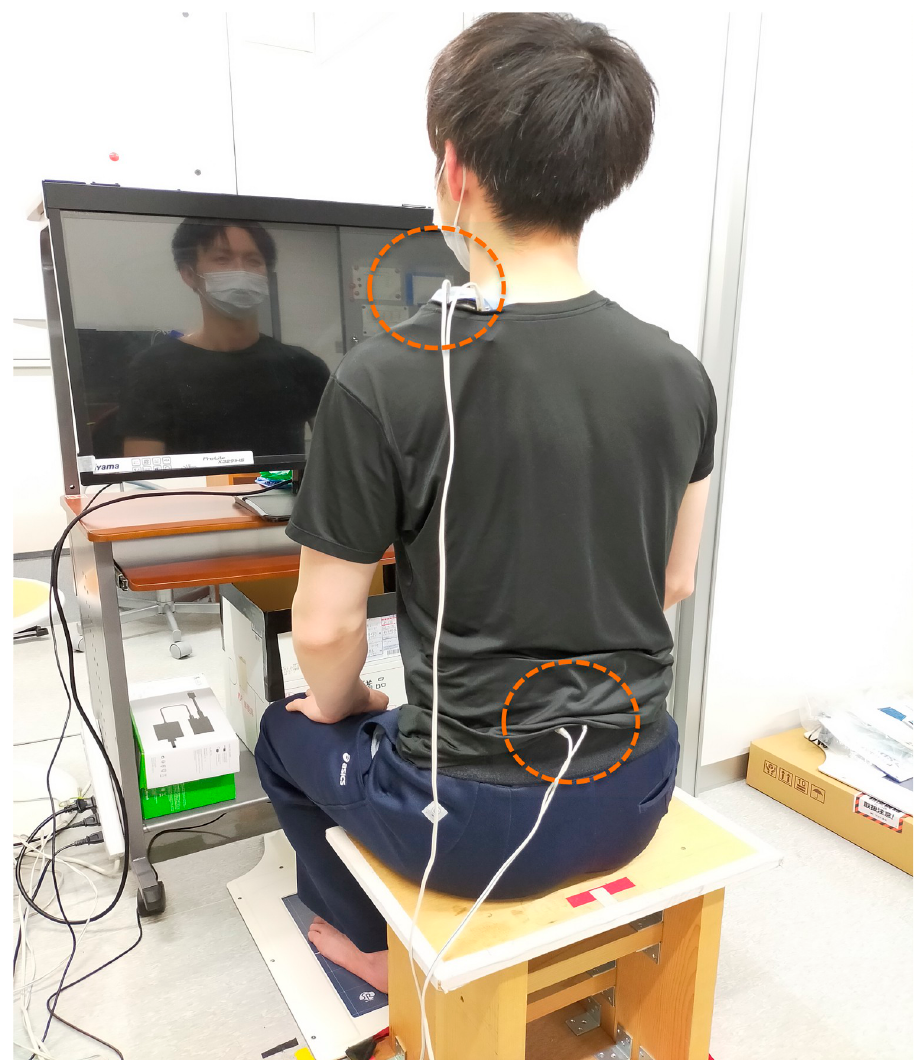
Fig 2. Location of vibratory stimulators. The vibratory stimulators are fixed in two circular positions in the sitting position. the left limb (WBL) [%] and the mean mediolateral (ML) and anteroposterior (AP) position [mm], pathlength [mm], and surface area [mm 2 ] of COP were calculated. The pathlength of COP represents the total trajectory followed by the COP from its initial position to its final position. The surface area of COP represents a rectangle bounded by the maximum width of the sway in the ML and AP directions. (NEWCOM Inc., Saitama, Japan) [25], which was placed in front of each participant. The posi- tion of the touch panel was adjusted such that when a participant reached it with their right index finger in an upright sitting position, the distance could be achieved with slight elbow flexion without excessive forward bending or trunk rotation. Participants were instructed to place their right index finger at the position of the manubrium of sternum in a closed eyes state. Subsequently, the participants were instructed to touch the location on the touch panel